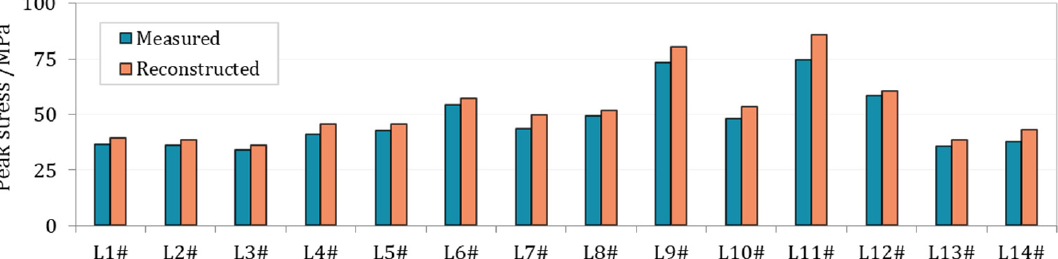
Figure 13. Bar plot of peak stress between measured and reconstructed values. NOTE: L1# repre ‐ sents the collective name of L1#SURF and L1#STRU, the same as in other points.